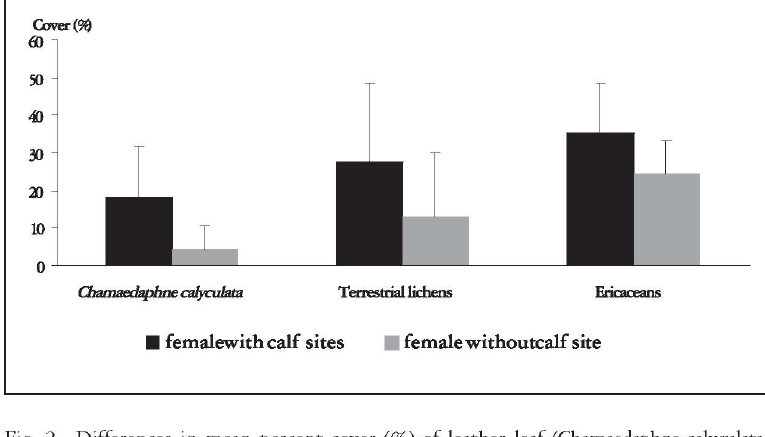
Fig. 2. Differences in mean percent cover (%) of leather leaf (Chamaedaphne calyculata) (P = 0.034 ), terrestrial lichens (P = 0.159 ) and other ericaceans (P=0.224) for the female with calf sites (n=7) and female without calf sites (n=7). areas" represents areas utilised by females during the calving period, i.e., from mid-May to mid-June. For each collared female, we generated minimum convex polygon home ranges that allowed the delin eation of calving areas. These areas covered between 3 to 5 km 2 (Lantin, unpubl. data). By flying over the